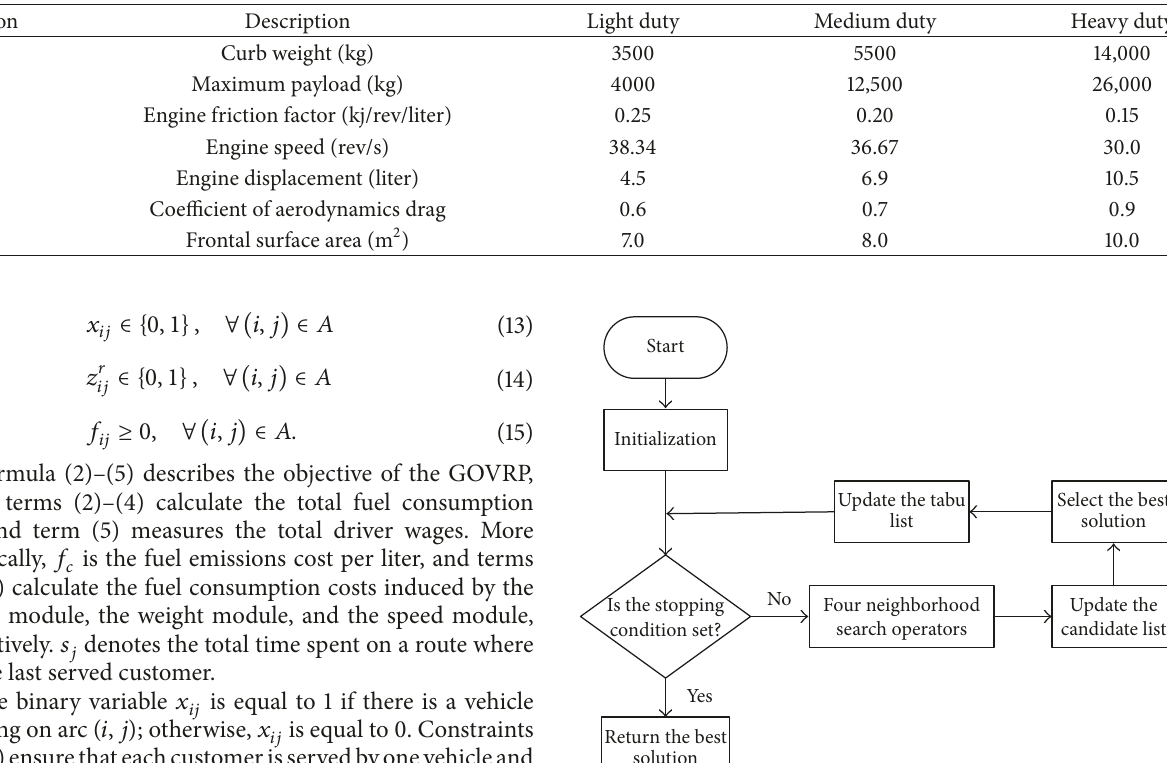
Table 2: Specific parameters for different vehicle types.